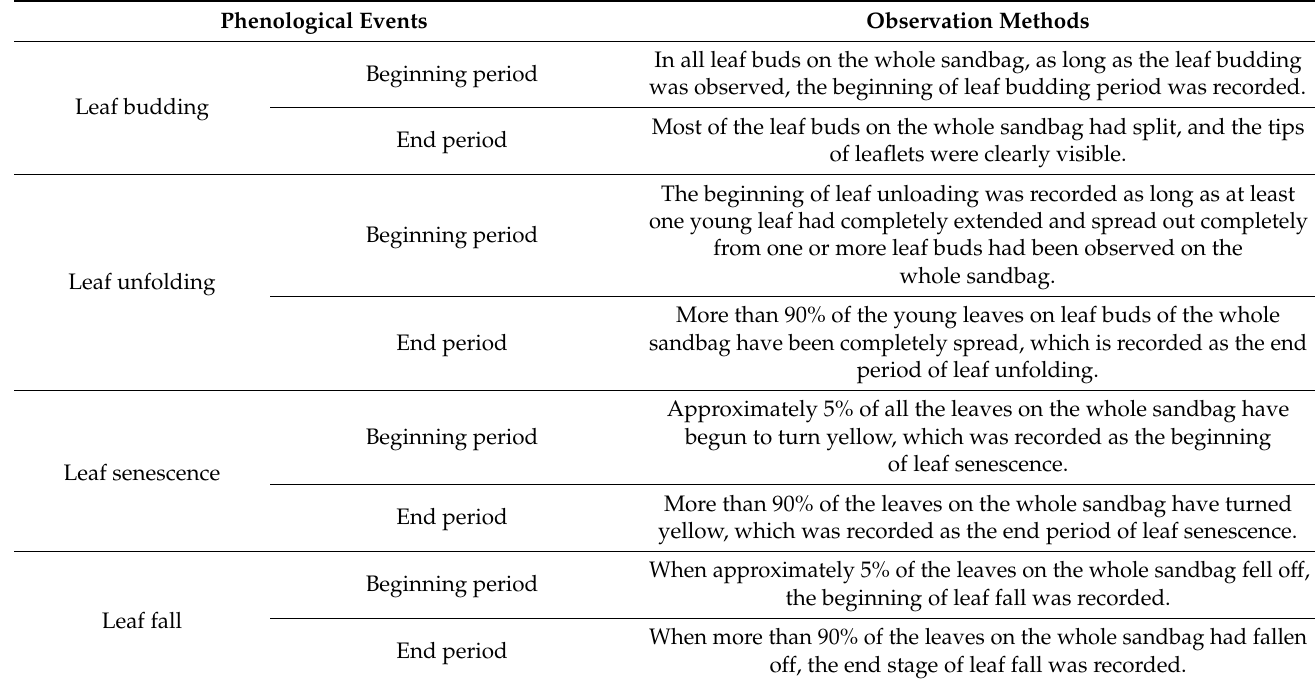
Table 3. Phenological observation and observation methods of Nitraria tangutorum